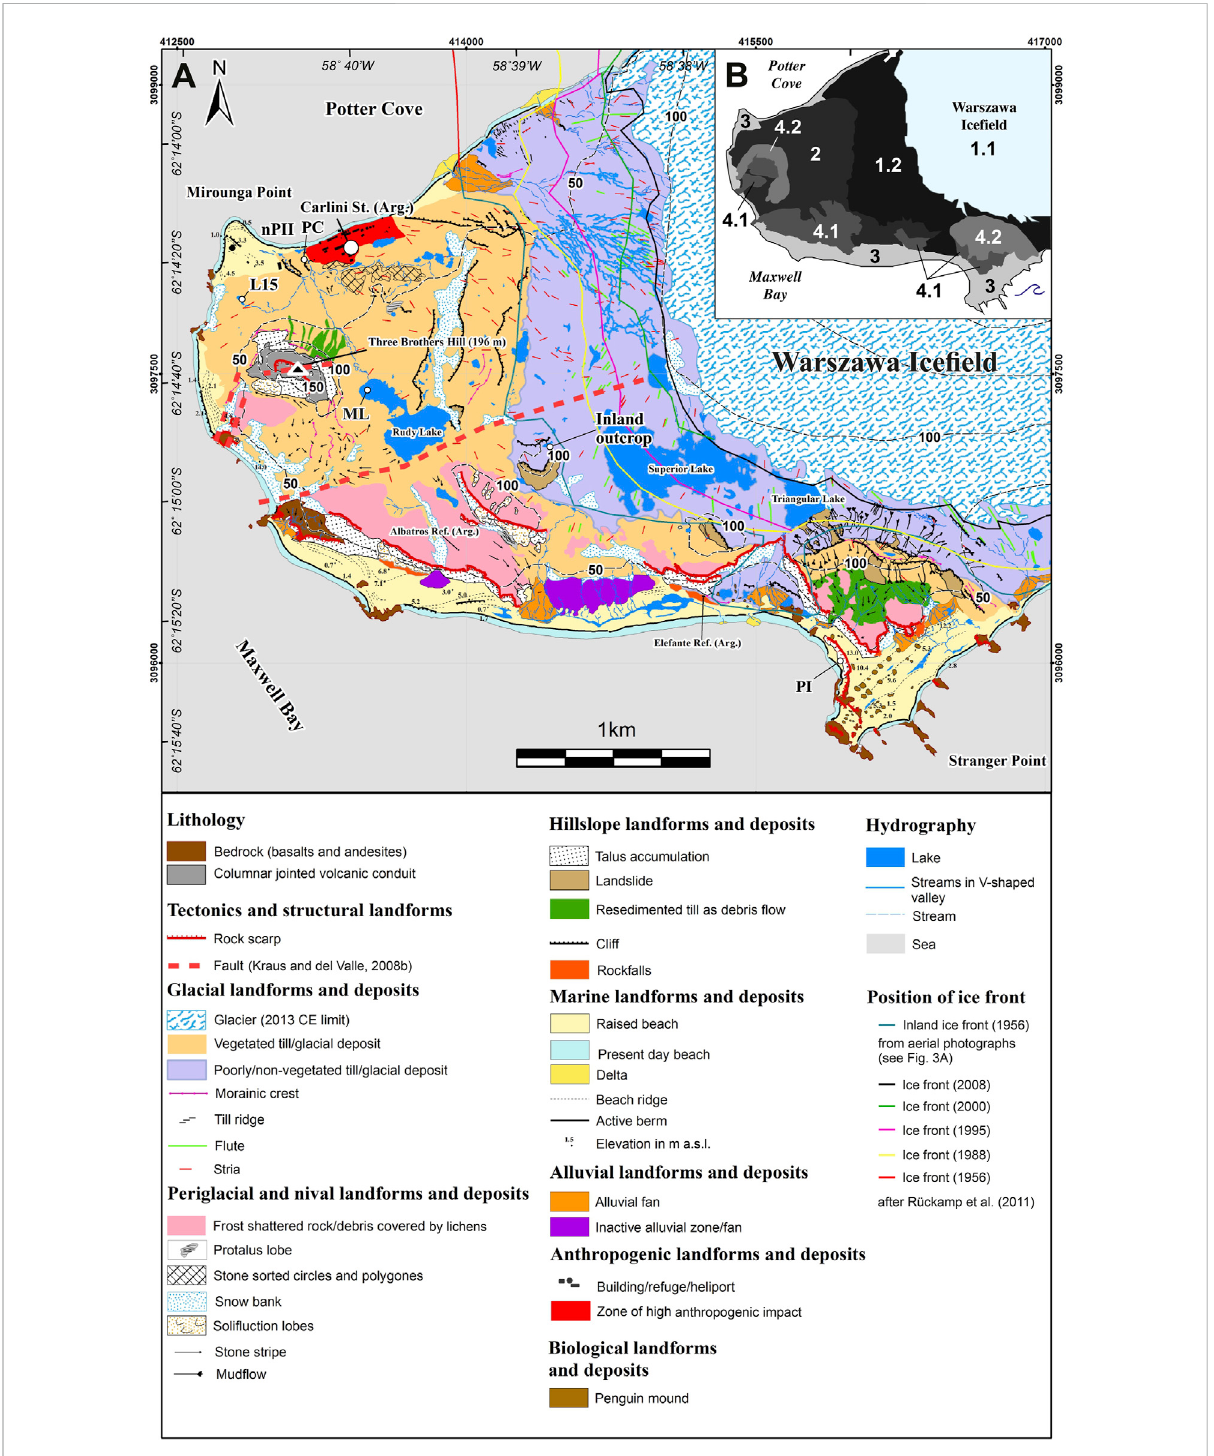
FIGURE 2 (A) Geomorphological map of Potter Peninsula showing landform assemblages in the main text and the location of key sites in this study: nPII, new Pingfo II section; PC, Potter Cove section (Sugden and John, 1973) and new Potter Cove section; L15, Lake L15; ML, Matias Lake, connected to Rudy Lake; PI is the Pingfo I section (del Valle et al., 2002). (B) Summary map of landform assemblage zones 1 – 4, subdivided as follows: 1.1) glacier and snow assemblage; 1.2) active glacial and proglacial sediment landform assemblage (deglaciated since 1956 CE); 2) moss and lichen vegetated inactive glacial landforms and deposits, including till deposits and inactive glacio fl uvial fans, deglaciated before 1956 CE; 3) paraglacial